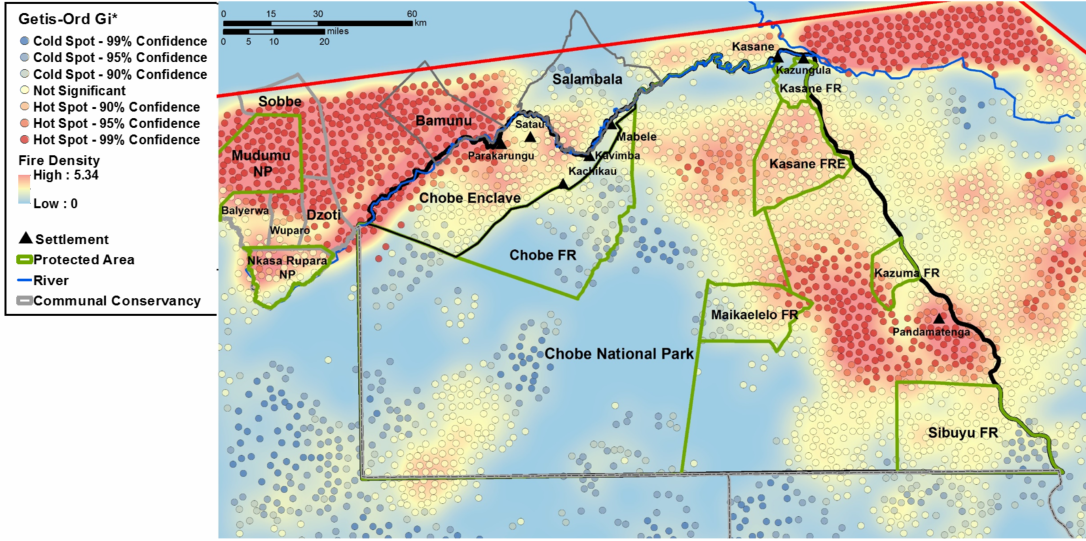
Figure 11. MODIS active fires (2001–2013, n = 33,631) for Chobe District and neighboring countries, showing kernel density (fires/10 km 2 ) overlaid with Getis-Ord Gi* hot and cold spot confidence level bins. The red line marks the spatial extent of MODIS fire data used in the